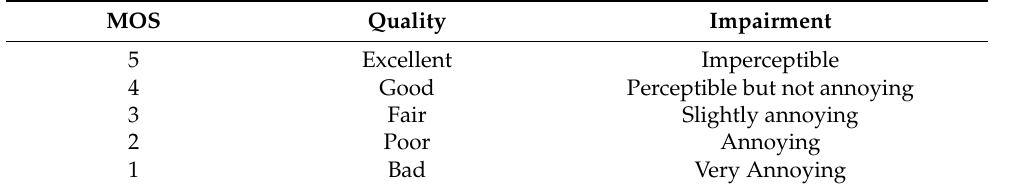
Table 1. The relationship between MOS and VoIP.